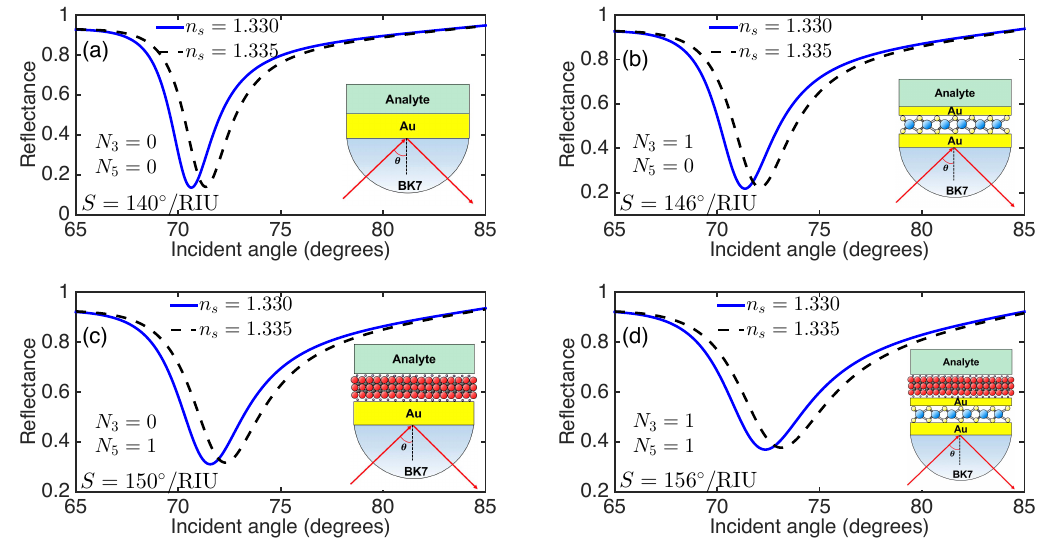
Figure 2. Reflectance as a function of the incident angle before (solid lines) and after (dashed lines) the variation of analyte refractive index (RI) for the Ti 3 C 2 T x -MoS 2 -based SPR sensor with ( a ) N 3 = 0, N 5 = 0, (i.e., no 2D materials); ( b ) N 3 = 1, N 5 = 0, (i.e., monolayer MoS 2 ); ( c ) N 3 = 0, N 5 = 1, (i.e., monolayer Ti 3 C 2 T x ), and ( d ) N 3 = 1, N 5 = 1, (i.e., monolayer MoS 2 and monolayer Ti 3 C 2 T x ).